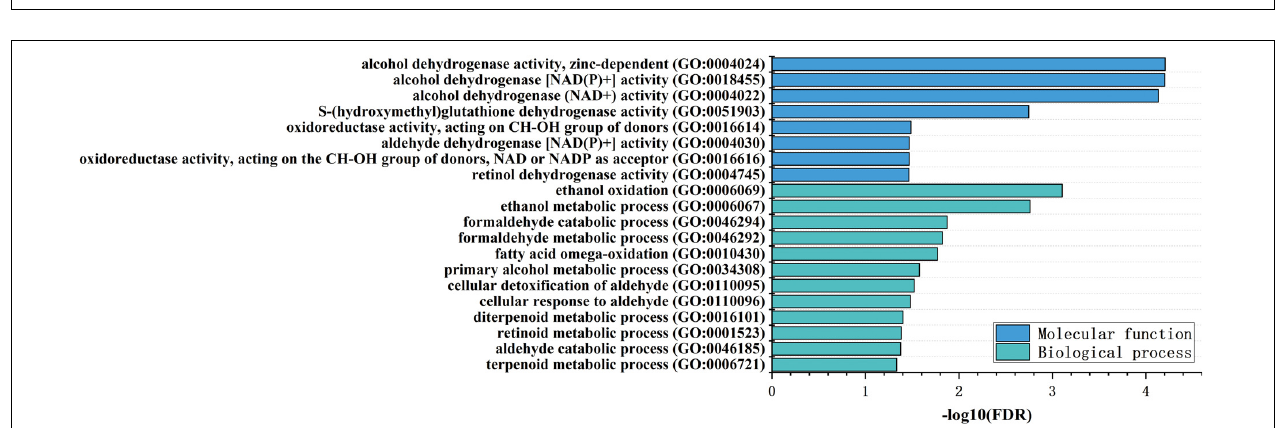
FIGURE 2 | The number of repetitions of SNP-Gene pairs.